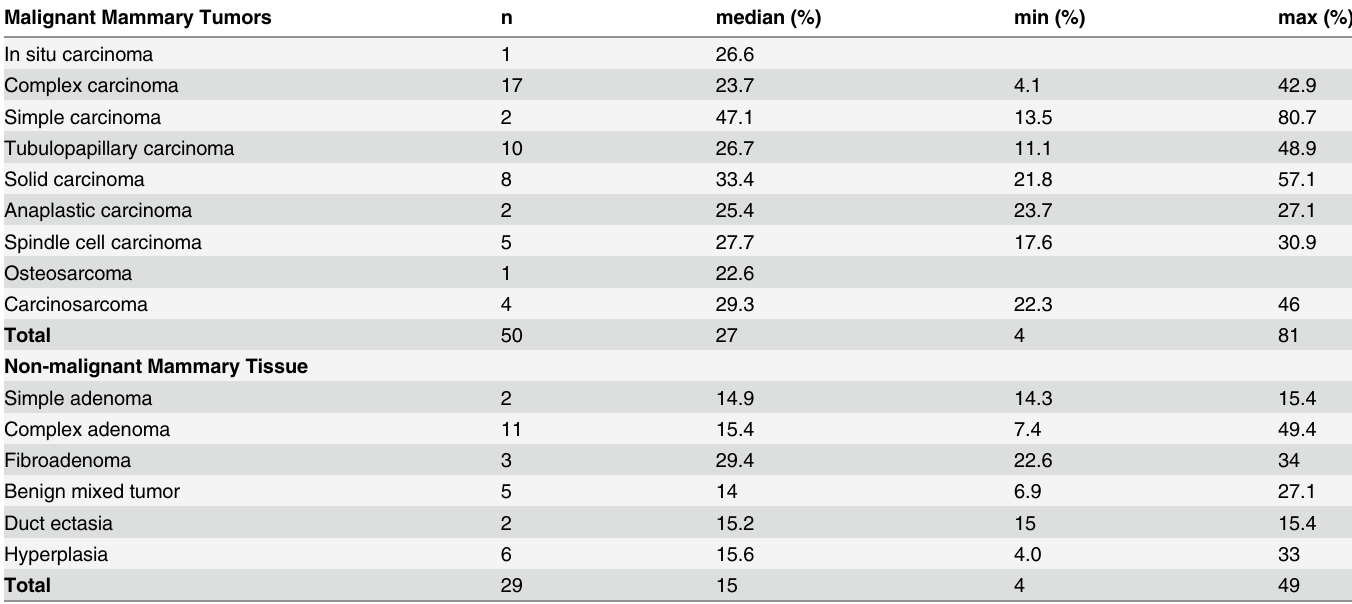
Table 2. Ki-67 score and SD in different tumor